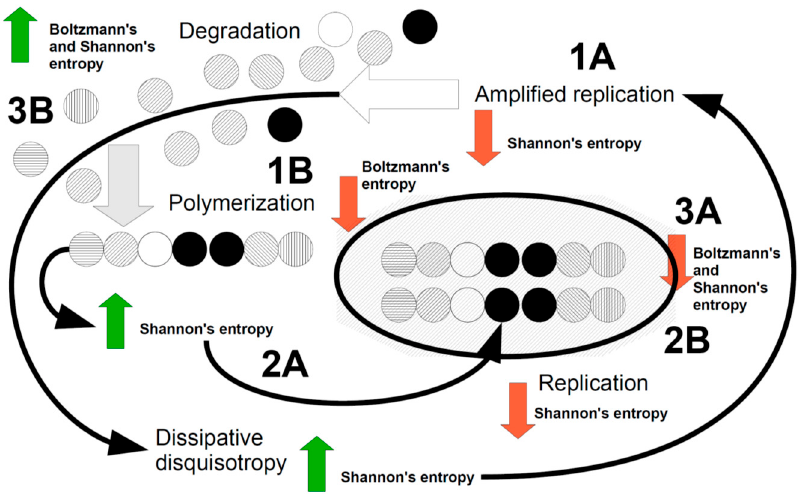
Figure 1. Cartoon showing the major dynamical events representing a living thing. The dissipative mechanism, in order to dissipate contrasting forces, replicates structures and/or functions (1A), usually increasing the E component of the Boltzmann space and reducing (red arrow) Shannon entropy. The energy is fueled by dissipation itself, via a rearrangement in the mesoscopic structure of water and of confined water. Replication may regard a single component in the Boltzmann space for example a single molecule or a single cell (amplification). Replication increases Boltzmann entropy, therefore the thermodynamic dissipation joins together elements in the Boltzmann space (energy fueled comes from dissipative mechanisms), creating polymers, which in turn increases Shannon entropy (green arrow) (2A). Polymers are joined to form macrostructures and more complex objects, so starting complexity, where both Boltzmann and Shannon entropy decrease (3A). At this stage, if degradation does not occur, (3B) the system might be halted and blocked. The increase in both Boltzmann and Shannon entropy restart the cycle. The energy for this step is given by thermodynamics (for Boltzmann) and the increase in disquisotropy associated with replication (1A), as any replicating event contains “imperfections”. This “dissipative disquisotropy” pushes Shannon to reduce entropy by replicating again and fueling the dissipation dynamics of the whole living